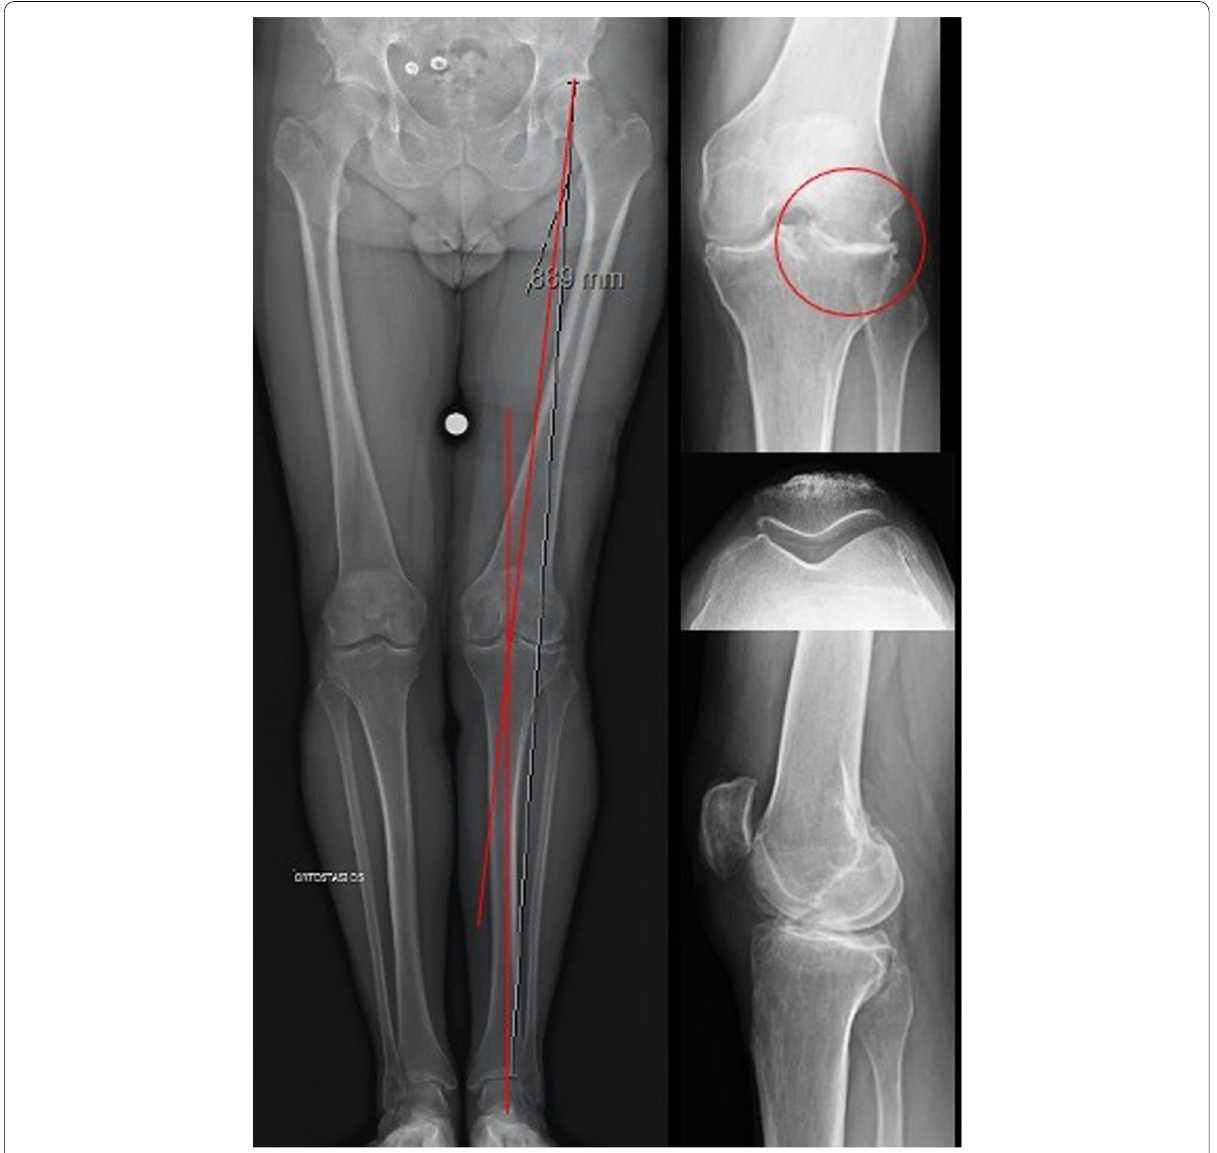
Fig. 1 Preoperative X-rays evaluation of a 56 years-old male with a native varus morphotype, who underwent a lateral open meniscectomy 15 years before in his left knee. Consequently, he developed a grade IV lateral OA, a grade III medial OA and a valgus